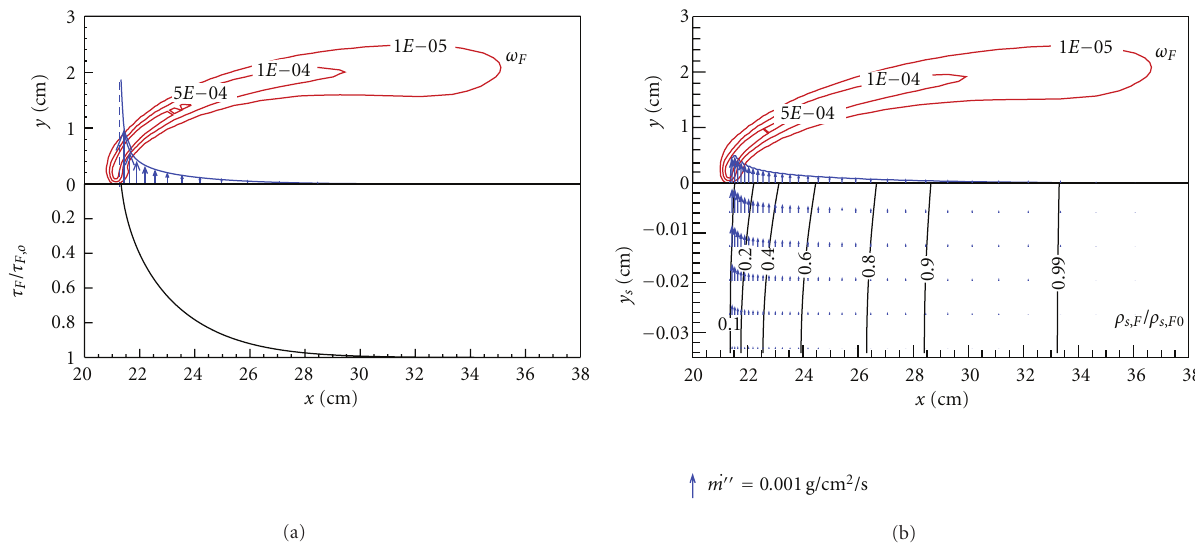
Figure 2: Flame structure, burning rate distribution, and the percentage of un-burnt solid at the steady state (a) with the zeroth-order pyrolysis model and (b) with the first-order pyrolysis model. Upper plane: contours of ω F (g/cm 3 s) and ˙ m (cid:3)(cid:3) distribution on the solid surface. Lower plane: (a) τ F /τ F ,0 (b) contours of ρ s , F /ρ s , F 0 , and fuel vapor mass flux in the solid. Flow condition: X O2, ∞ = 21%, V ∞ = 5cm/s, and ρ s , F 0 τ = 28 . 4mg/cm 2